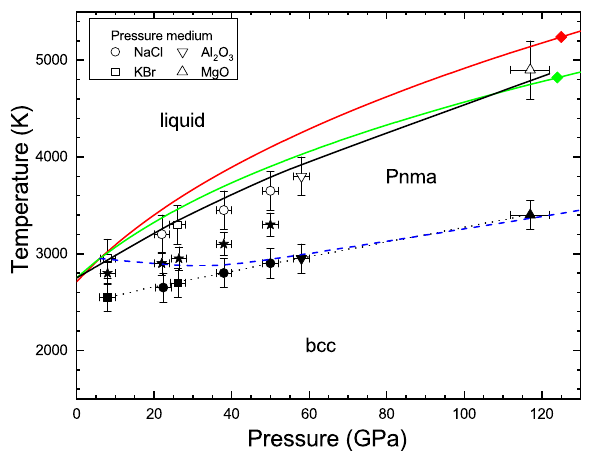
Fig. 5 The low-pressure portion of Fig. 6, including the experimental results of this work. Different symbols correspond to experiments done using different pressure media (see inset). Black solid symbols and black dotted line: the onset of recrystallization. Black empty symbols: the onset of melting. Black solid line: the Simon – Glatzel fi t to the experimental melting points. Green and red lines: the quantum molecular dynamics (QMD) melting curves of body-centered bcc-Nb and orthorhombic Pnma -Nb, respectively. Black stars are the pressure – temperature points, where the Pnma structure is detected in experiment. Blue dashed line: the theoretical bcc- Pnma phase boundary from this work. The error bars of the QMD melting points (green and red diamonds) are smaller than the size of the corresponding